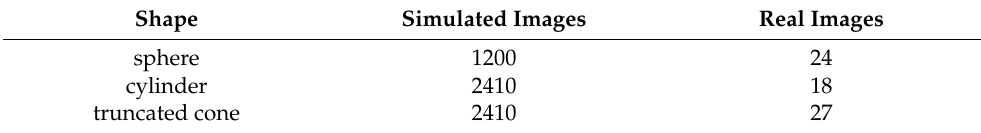
Table 3. Number of experimental data set.